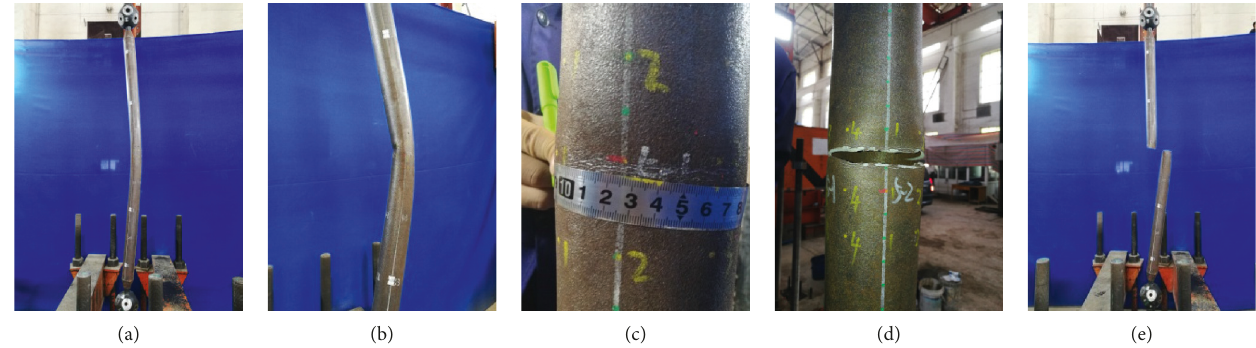
Figure 12: Characteristic points of test process. (a) Integral bending deformation, (b) local dent, (c) crack initiation, (d) specimen cracking, and (e) specimen